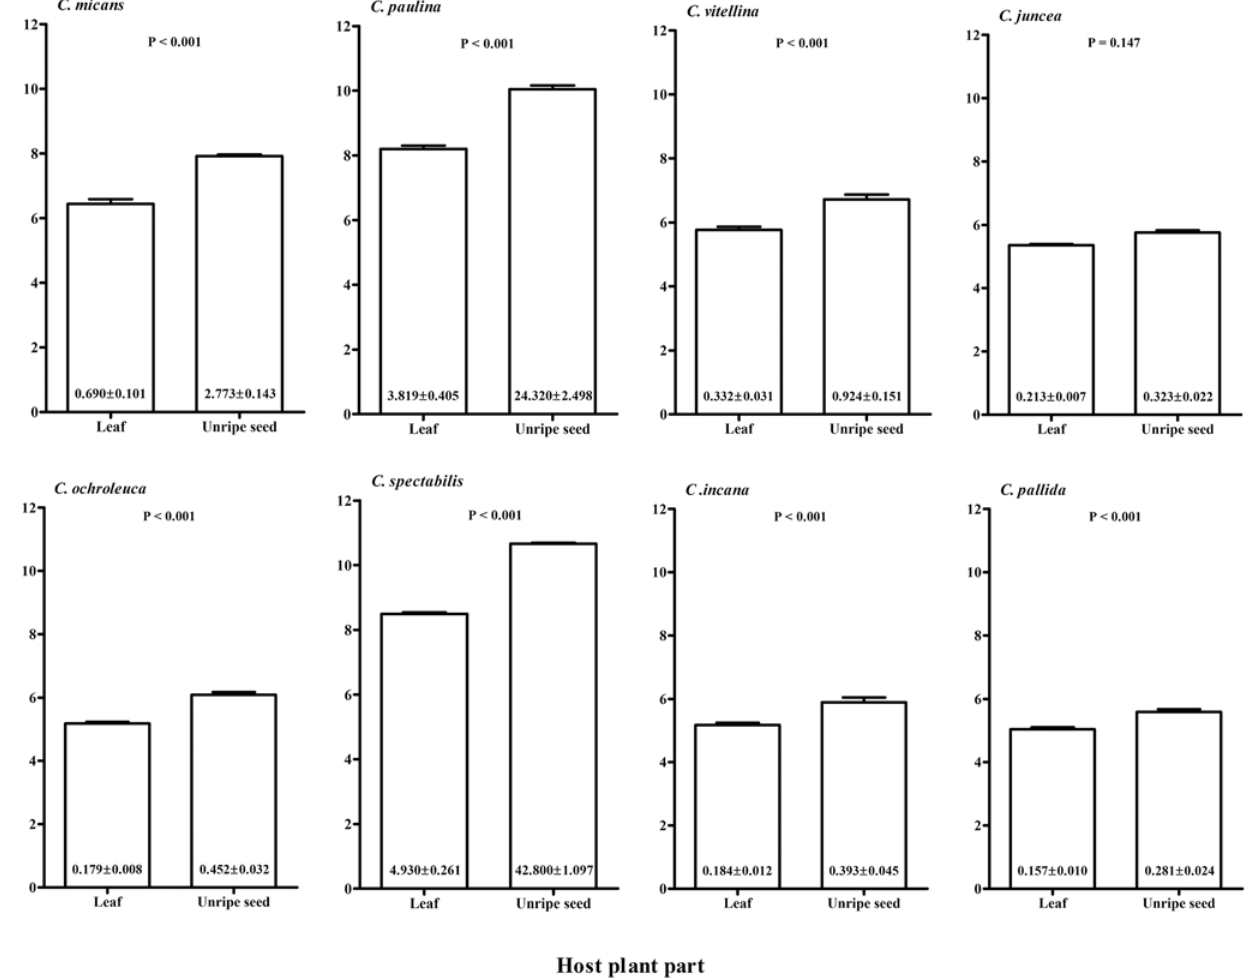
Fig 5. Concentration of pyrrolizidine alkaloids (mean ± se) in leaves and unripe seeds of Crotalaria species, which were used to rear Utetheisa ornatrix larvae. The concentration is given in ln transformed data ( μ g/g dry weight). The numbers inside the bars represent the mean ± SE of untransformed data in μ g/mg dry weight. The probability that the PA concentration in leaves and seeds, for each host plant, is significantly different is given above the bars ( post hoc Tukey